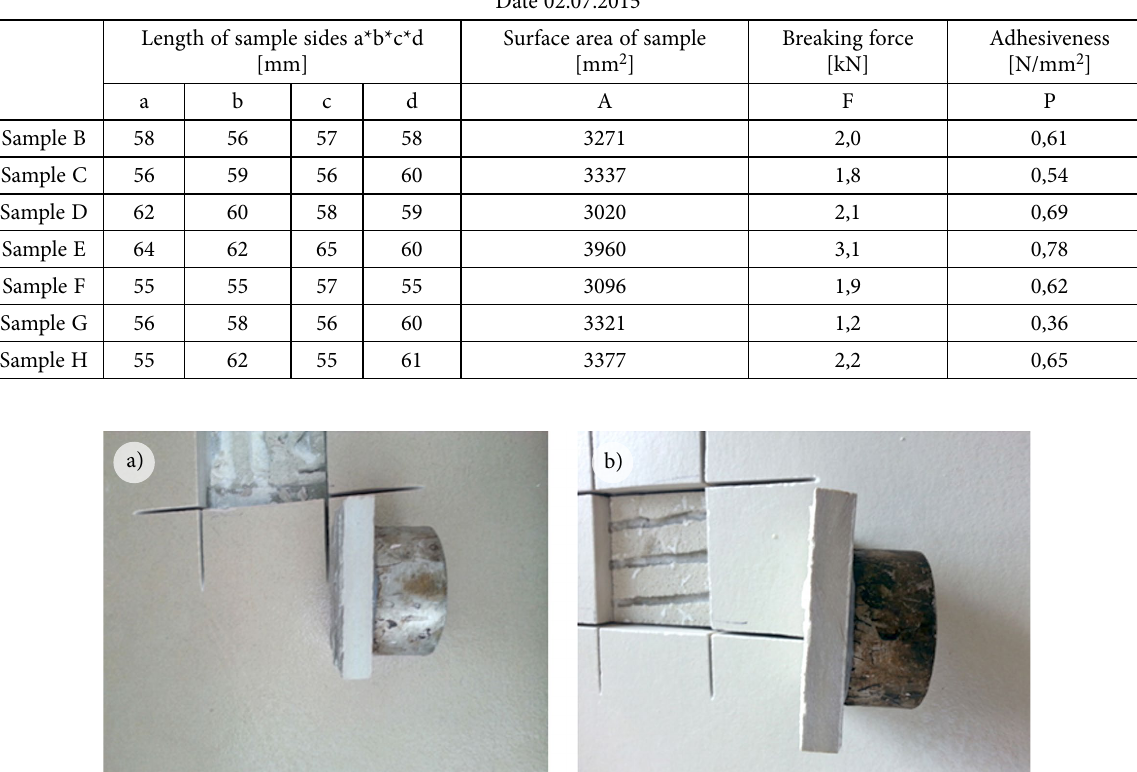
Fig. 6. Exterior samples taken after the adhesion test – breaking the adhesive: a – left side; b – right side